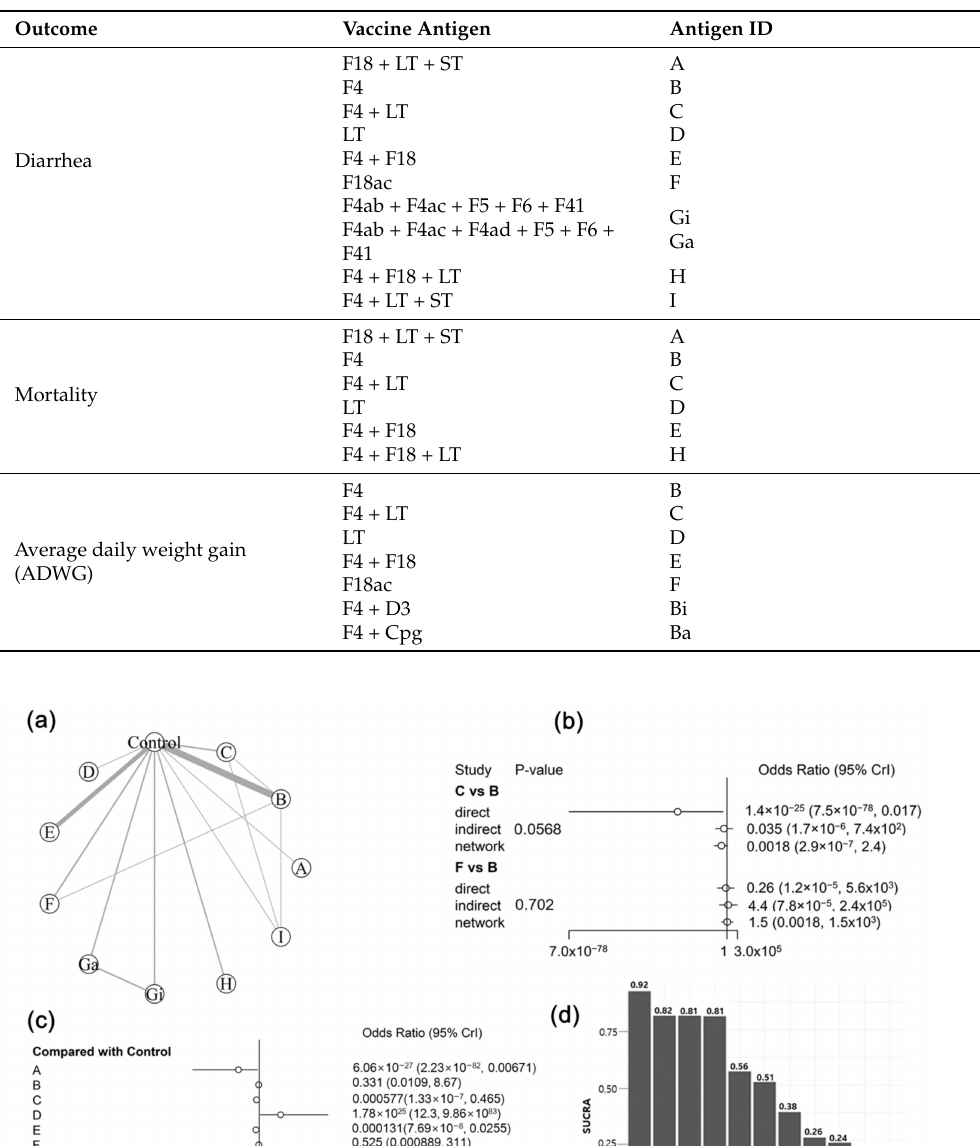
Table 4. List of target antigens included in the vaccines compared in the Bayesian NMA.